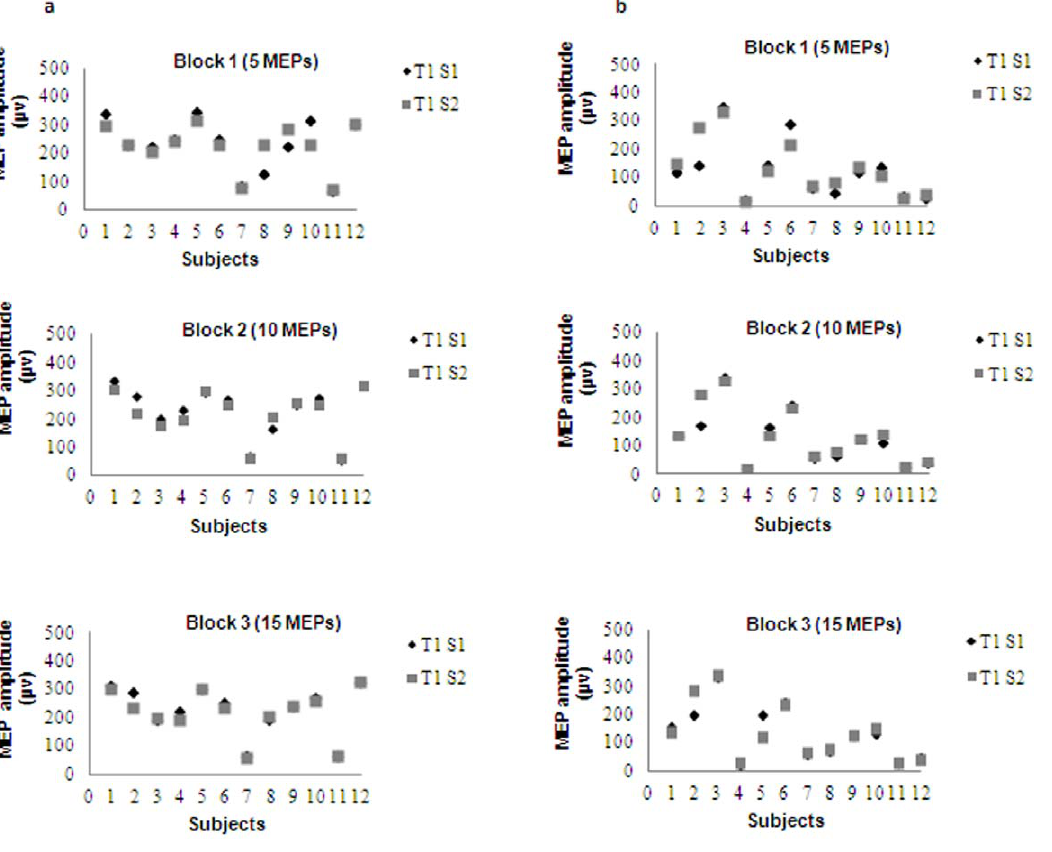
Figure 3. Comparison of MEPs amplitude in 12 subjects between two sessions. a) ECR and b) FDI muscle with 5, 10 and 15 MEPs per block in three time points.